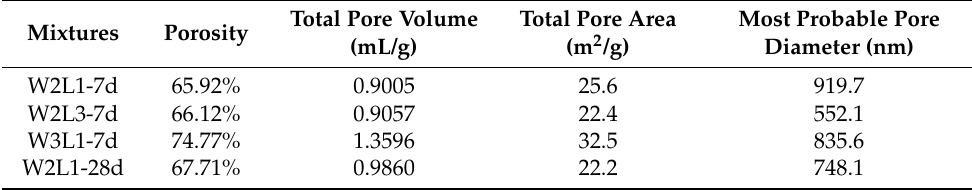
Table 3. The characteristic parameters of MIP pore structure for the high water grouting material samples with different